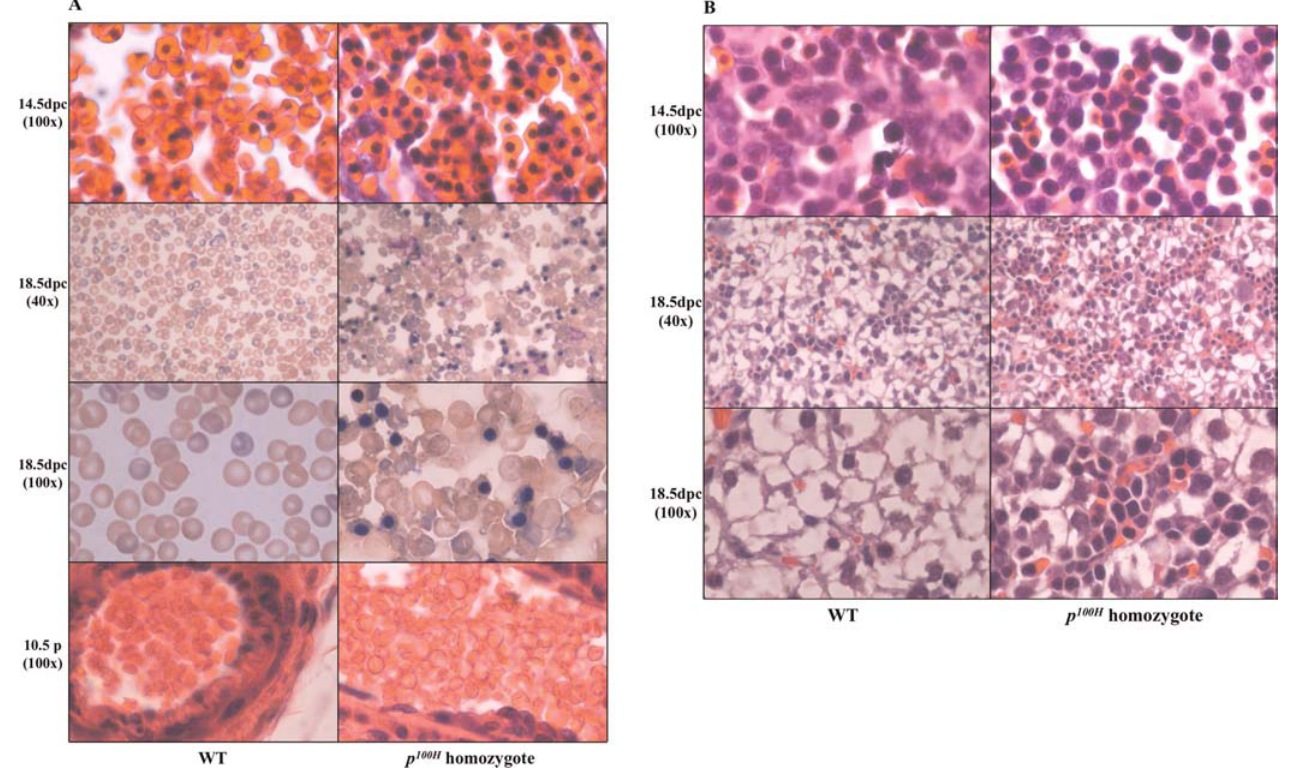
Figure 7. The Blood and Liver Phenotype of WT and p 100H Homozygous Mice (A) Red blood cells of WT mice (left panels) and p 100H homozygous mice (right panels) are shown at the indicated ages. (B) Liver cells of WT mice (left panels) and p 100H homozygous mice (right panels) are shown at the indicated